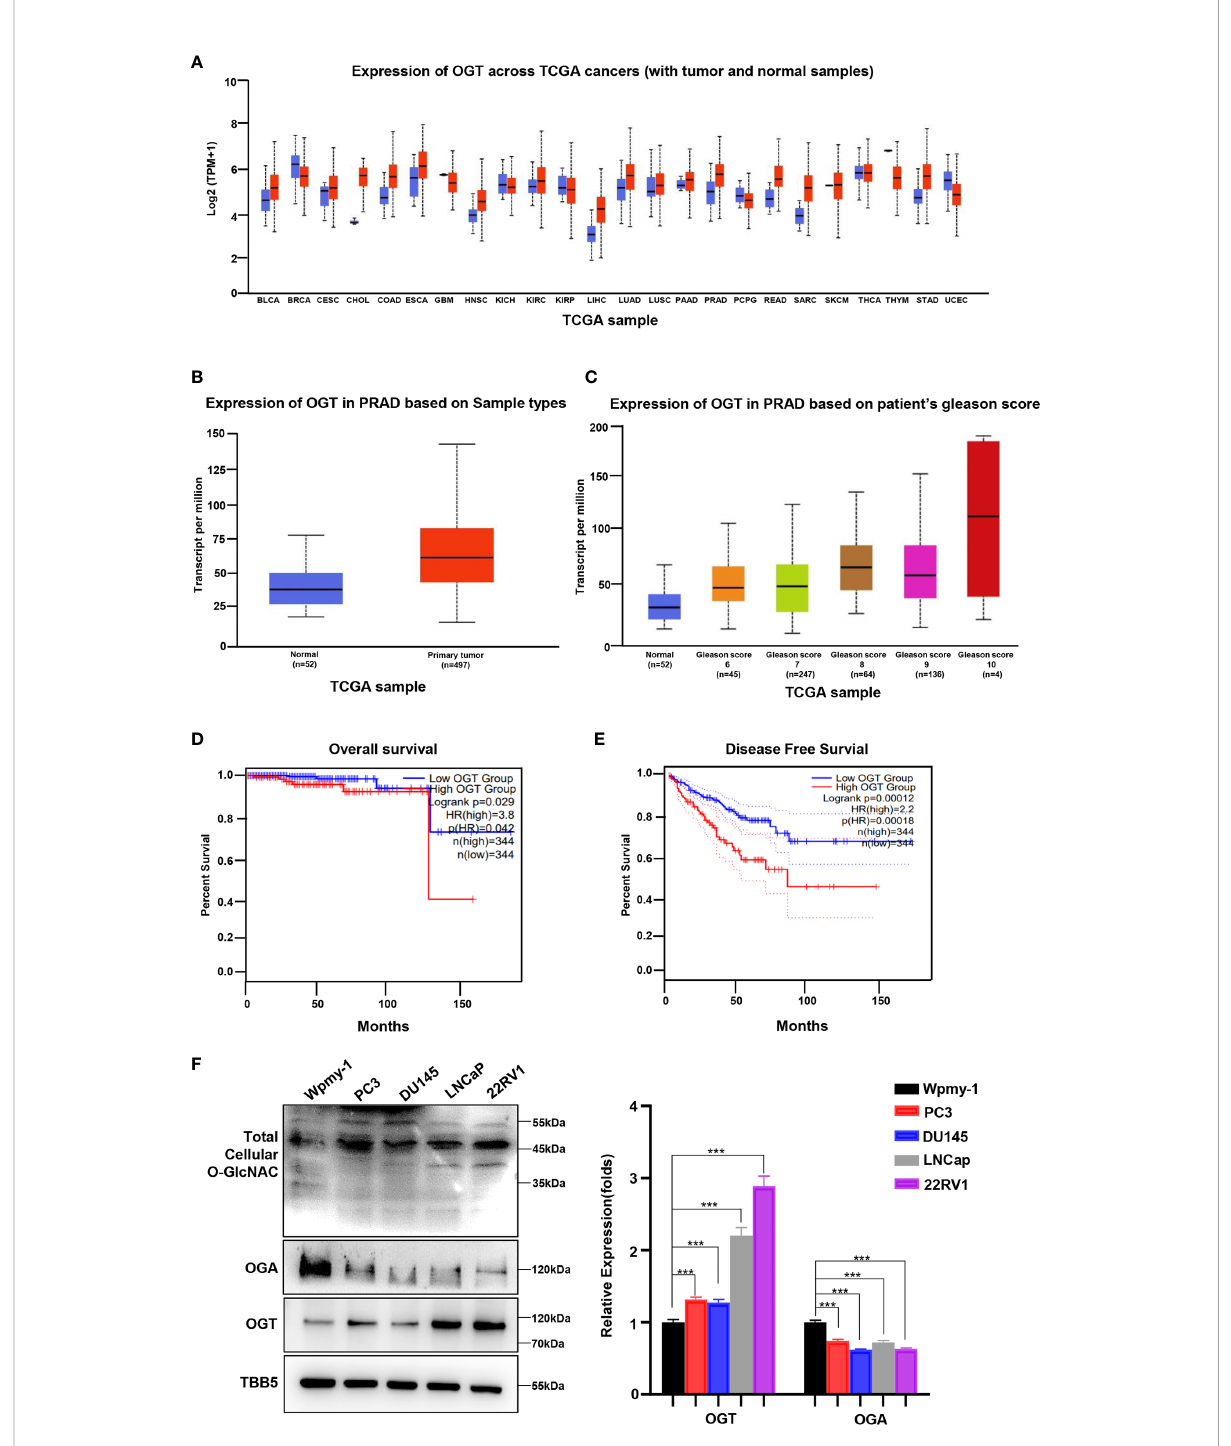
FIGURE 1 OGT is overexpressed in PC and contributes poor diagnosis in PC patients. (A) The expression level of OGT in different kinds of cancers and normal tissues from TCGA patient samples. (B) The expression level of OGT in primary prostate cancer tissues (n=497) and normal tissues (n=52) from TCGA patient samples. (C) OGT expression based on Gleason score from TCGA samples. (D) Kaplan – Meier analysis of the overall survival of patients with prostate cancer. The cut off value is 0.3. (E) The disease-free survival analysis of prostate cancer patients with high or low OGT expression from TCGA. The cut off value is 0.3. (F) Protein levels of OGT, OGA and total cellular O-GlcNAc in AR-positive (LNCaP, 22RV1) and AR-negative (PC3, DU145) PC cell lines and normal prostatic matrix immortalized cell (wpmy-1). *p < 0.05; **p < 0.01; ***p < 0.001 (Student ’ s